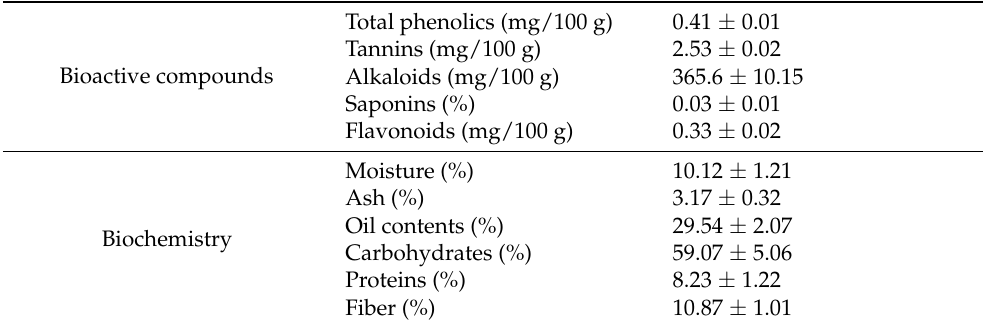
Table 3. Mean ( ± SE) of bioactive compounds and proximate composition of M. fragrans .